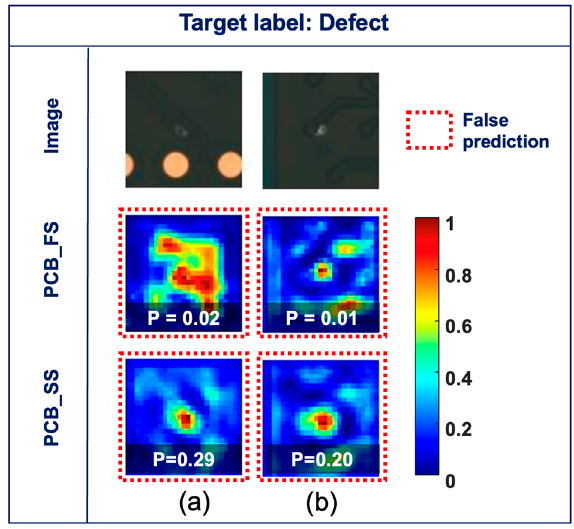
Figure 9. Examples of defect images (a) and (b) misclassi fi ed by both models.